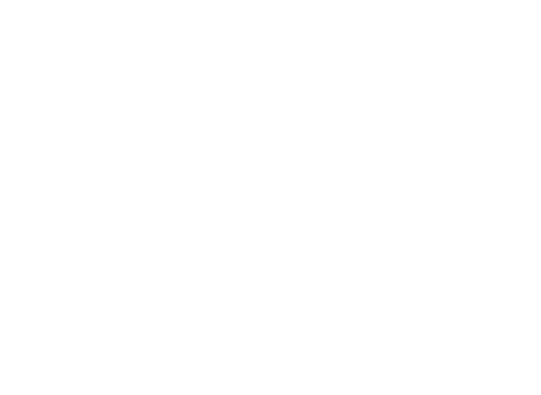
Figure 5. Changes in the contact angle of uncoated Scots pine and biofinish-coated wood as a function of exposure time. Note: Error bars correspond to the range (minimum–maximum) of results observed.